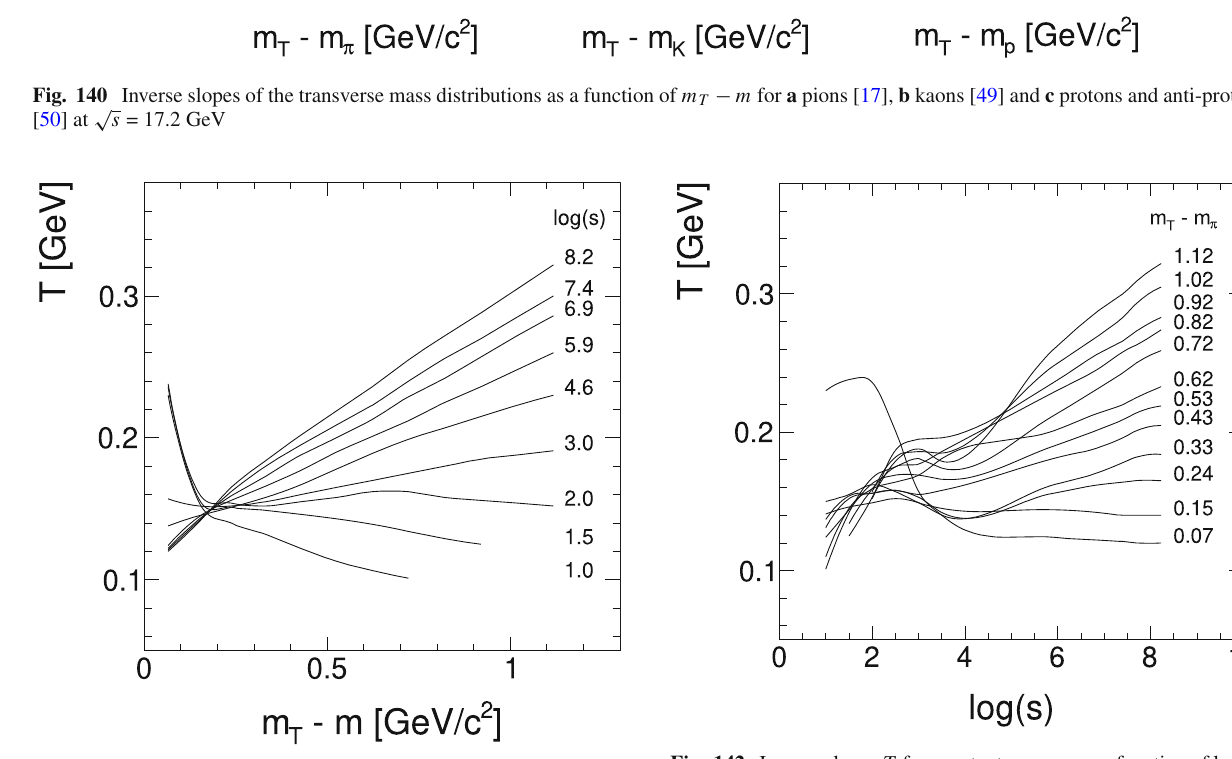
not applicable in a p T range of 0.4 to 1.3 GeV/c. In addition